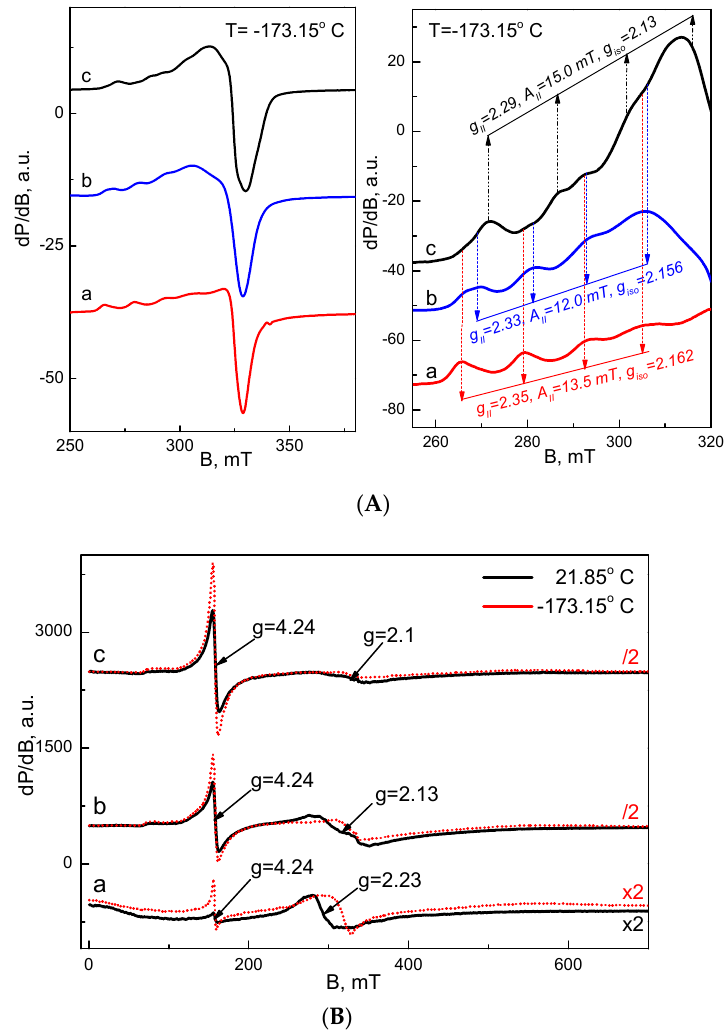
Figure 6. EPR spectra at − 173.15 °C of Cu 2+ ( A ) and at − 173.15 °C and 21.85 °C of Fe 3+ ( B ) complexes of: crPVA mat (a), cr(PVA/Ch) mat (b) and cr(PVA/Ch)/SQ (10 wt% SQ) mat (c). The EPR spectrum of the Cu 2+ complex of the crPVA mat consisted of an anisotropic signal with the following parameters: g || = 2.35, g ⊥ = 2.06 and A || = 13.5 mT (Figure 6A(a)). These parameters are in good agreement with those previously published [61–63] (Table 1). Table 1. EPR data for Cu 2+ complexes with different ligands—SQ, PVA and Ch. Cu 2+ Complex g II A II (mT) Cu 2+ -SQ (this work)